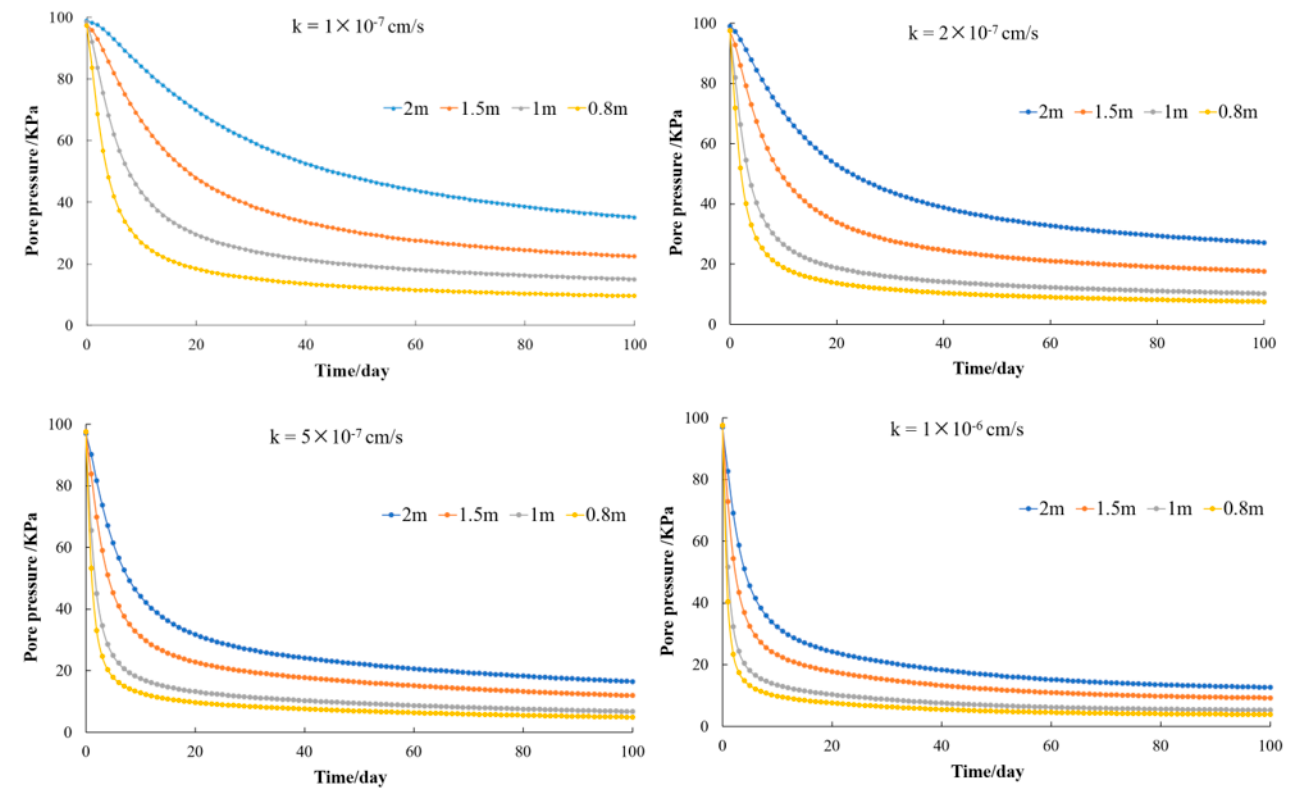
Figure 8. Pore water pressure at a depth of 10 m changes over time under di ff erent spacings.